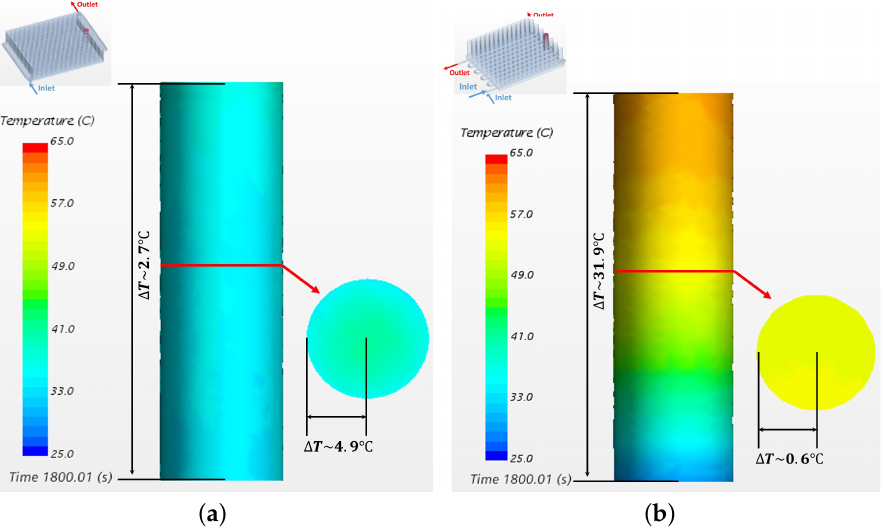
Figure 9. Contours of temperature in (°C) on the outer surface of one Li-ion cell within the module for, ( a ) immersion cooling, and ( b )